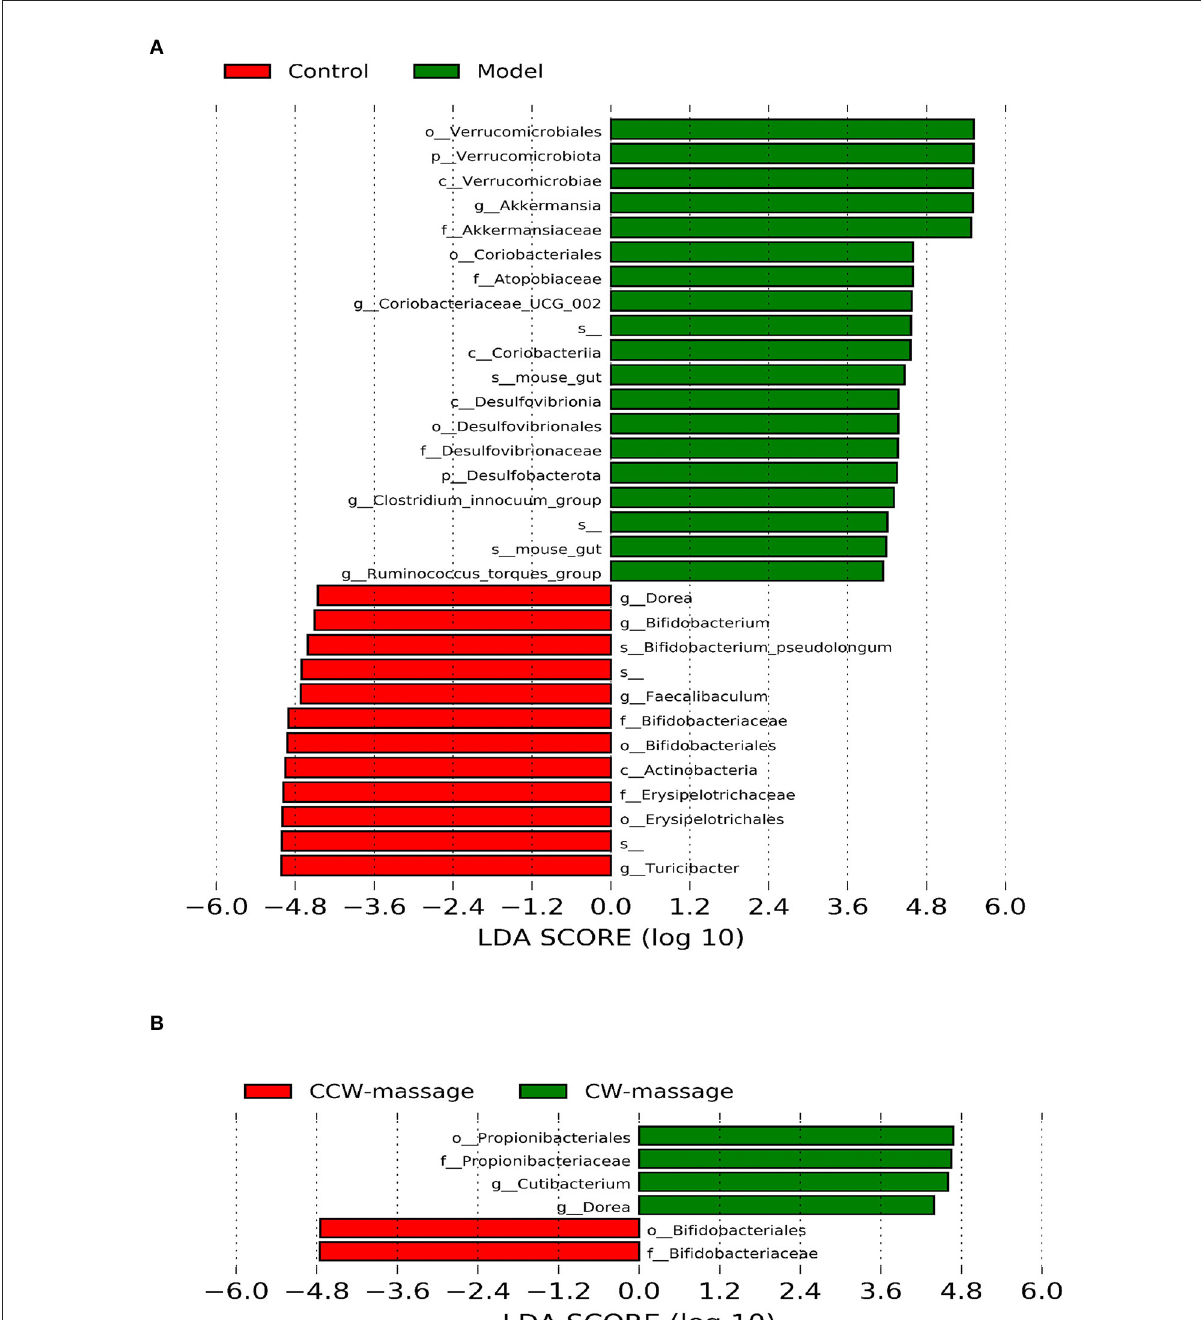
FIGURE5 LDA effect size identifies differential abundance of bacteria between the control group and model group (A) , or between the sham-massage, CW-massage, and CCW-massage group (B) , LDA > 2.0, P < 0.05.